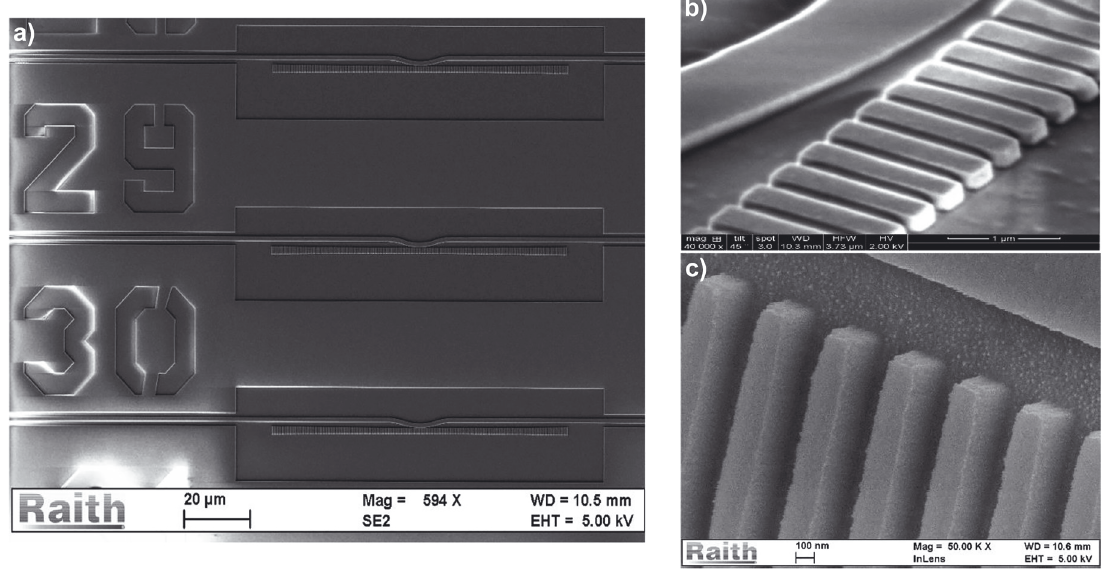
Figure 6: SEM pictures of the fabricated devices: (a) SEM image of the quadratically tapered devices taken normal to the chip surface, (b) SEM image of the rectangular cross-section devices taken at a 45 ◦ angle and (c) SEM image of the trapezoidal cross-section devices taken at a 45 ◦ and measuring an etching angle of ∼ 7 ◦